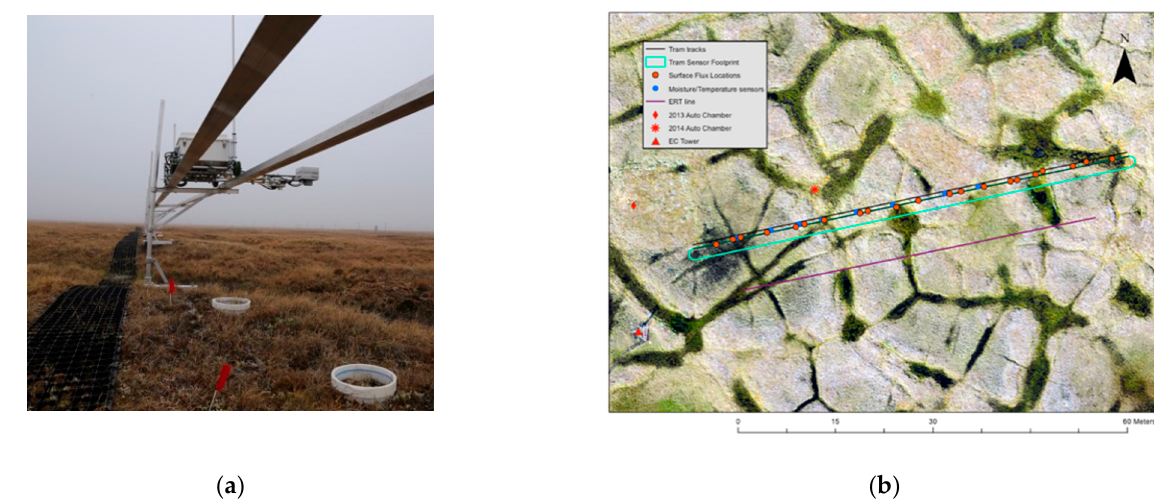
Figure 3. ( a ) Tram system installed at the NGEE-Arctic site, and ( b ) the aerial image of the tram track location with the point-measurement locations. In ( a ), the tram moves on two rails, carrying a sensor package on its arm. The flux chambers can be seen on the ground.